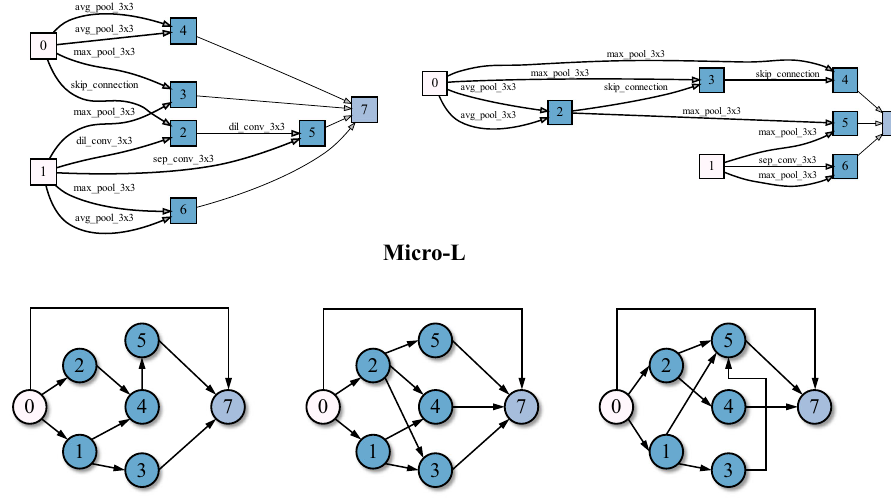
Fig. 2 The visualization of Micro-L and Macro-L